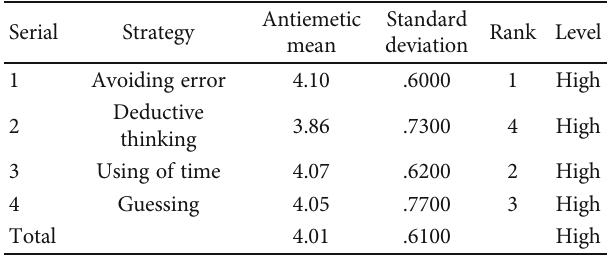
Table 5: Arithmetic means and standard deviations of the test wiseness strategies according (gender, faculty, and the academic